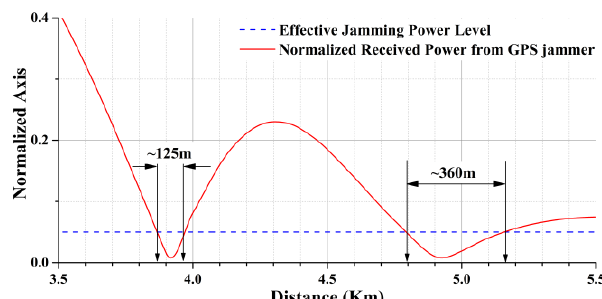
Figure 6. the Reinstate Time of incoming missile with OH scenario of